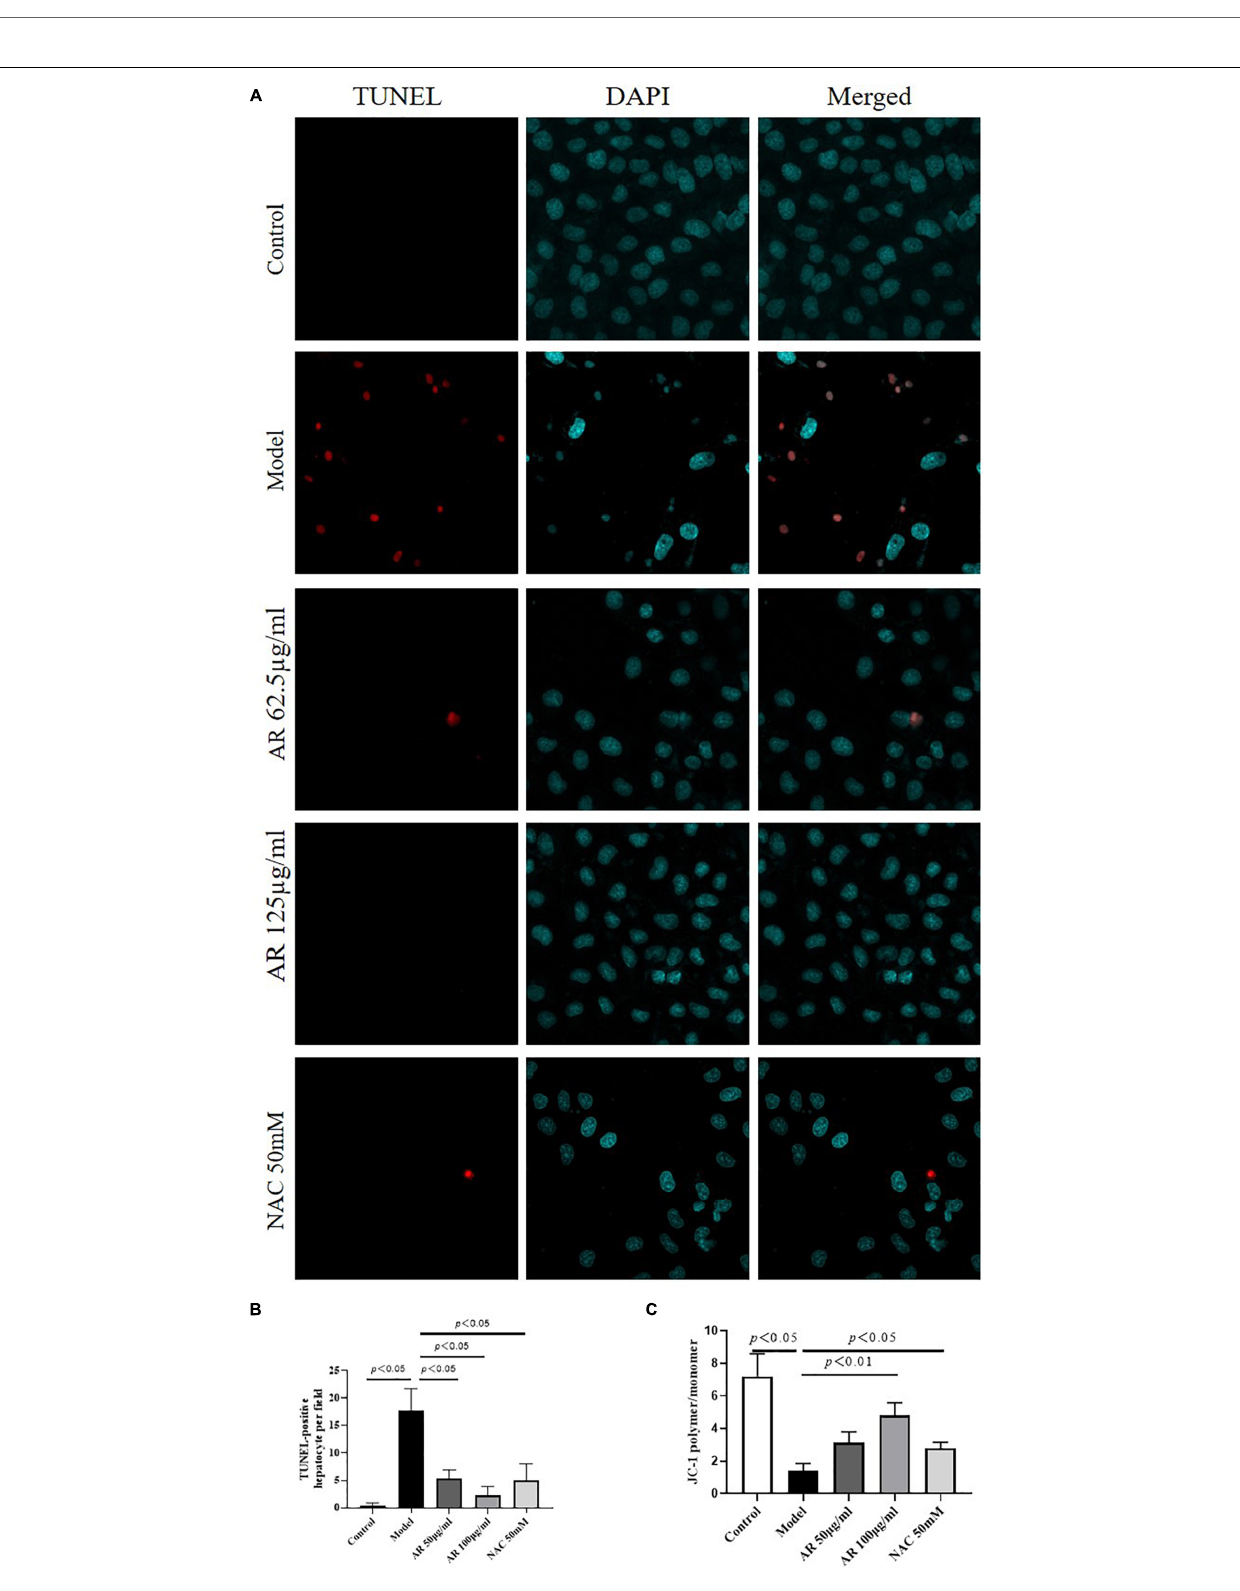
Frontiers in Medicine |